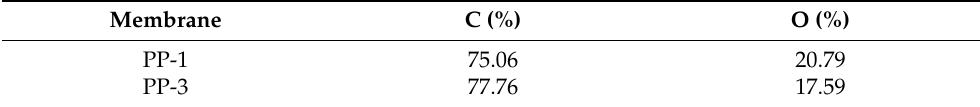
Figure 6. ( a ): XPS full-scan spectra of PP-1 and PP-3 membrane; ( b , c ): C1s spectra of PP-1 and PP-3 membrane; ( d , e ): O1s spectra of PP-1 and PP-3 membrane. Table 5. Elemental composition by atomic percent of different kinds of PES/PEI membranes.